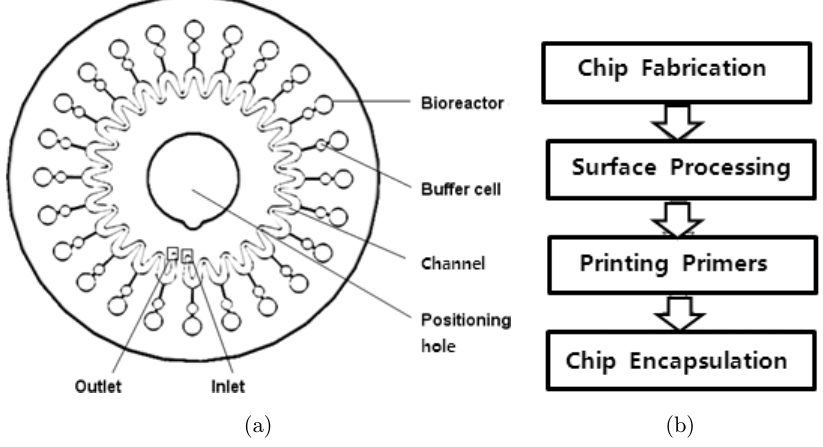
Fig. 1. Structure of the micro°uidic